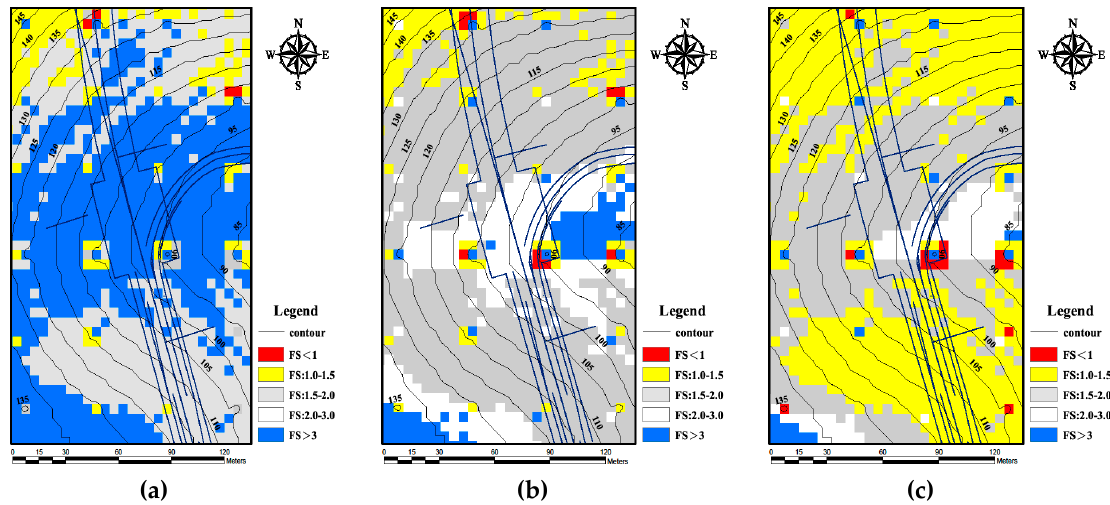
Figure 10. Influence of the tunnel entrance elevation on the safety factor of slopes with cutting slope ratio 1.0:1.0. ( a ) Portal locations elevation of 90 m, FS > 3. ( b ) Portal locations elevation of 95 m, FS : 2.0–3.0. ( c ) Portal locations elevation of 100 m, FS : 1.5–2.0.